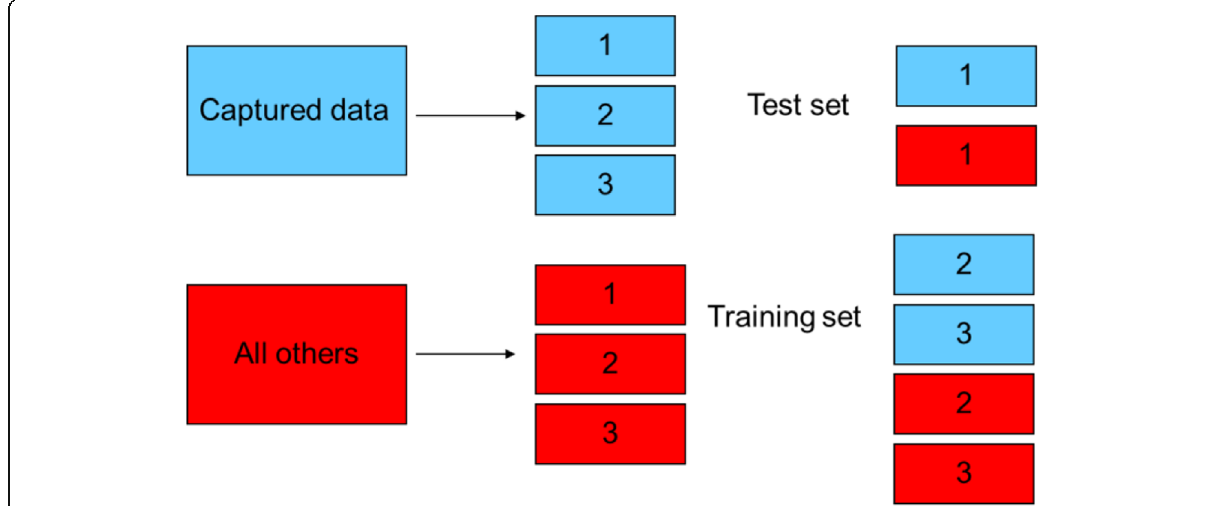
Fig. 5 Two phases in the model of the fault detection solution